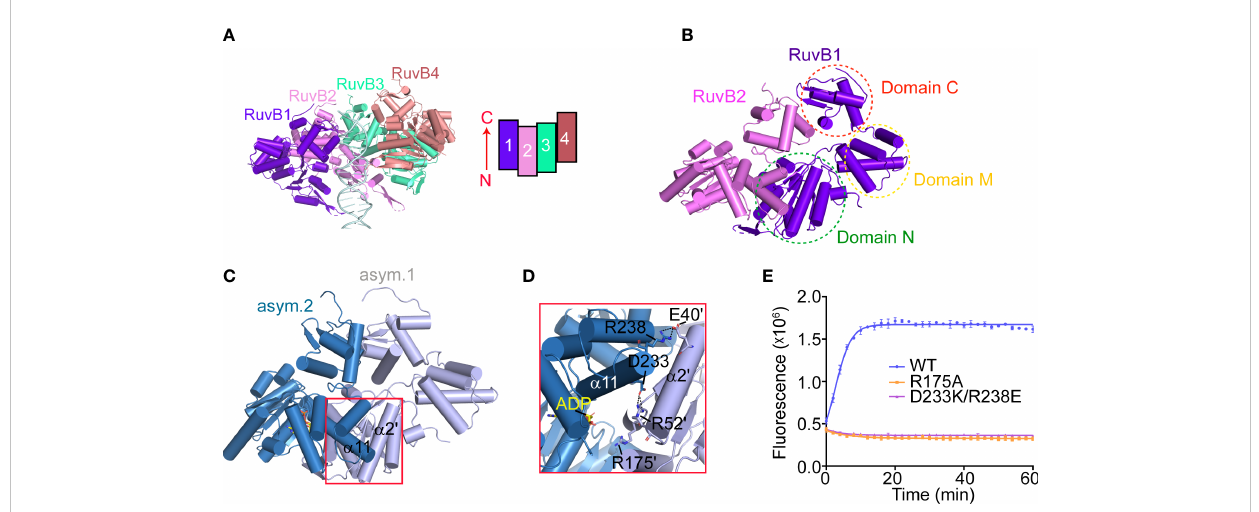
FIGURE 5 The packing pattern adopted by PaRuvB subunits in the cryo-EM structure. (A) Cartoon representation of the RuvB-dsDNA complex. a -helices are shown in cylinder. DNA duplex is shown in ladder representation. The relative orientation and packing pattern of each RuvB subunit are illustrated on the top-left. (B) The dimerization between RuvB1 and RuvB2 as shown in (A) The three domains (N, M and C) of RuvB are indicated. (C) The dimerization interface of RuvB subunits revealed by crystal packing. (D) Close-up view of the RuvB intersubunit binding region de fi ned in (C) . Key interacting residues are shown in sticks and labeled. Dashed lines indicate electrostatic interactions. (E) Effects of indicated mutations on the HJ branch migration activities of RuvAB by FRET-based assay. Values are means ± s.d., n = 3 independent